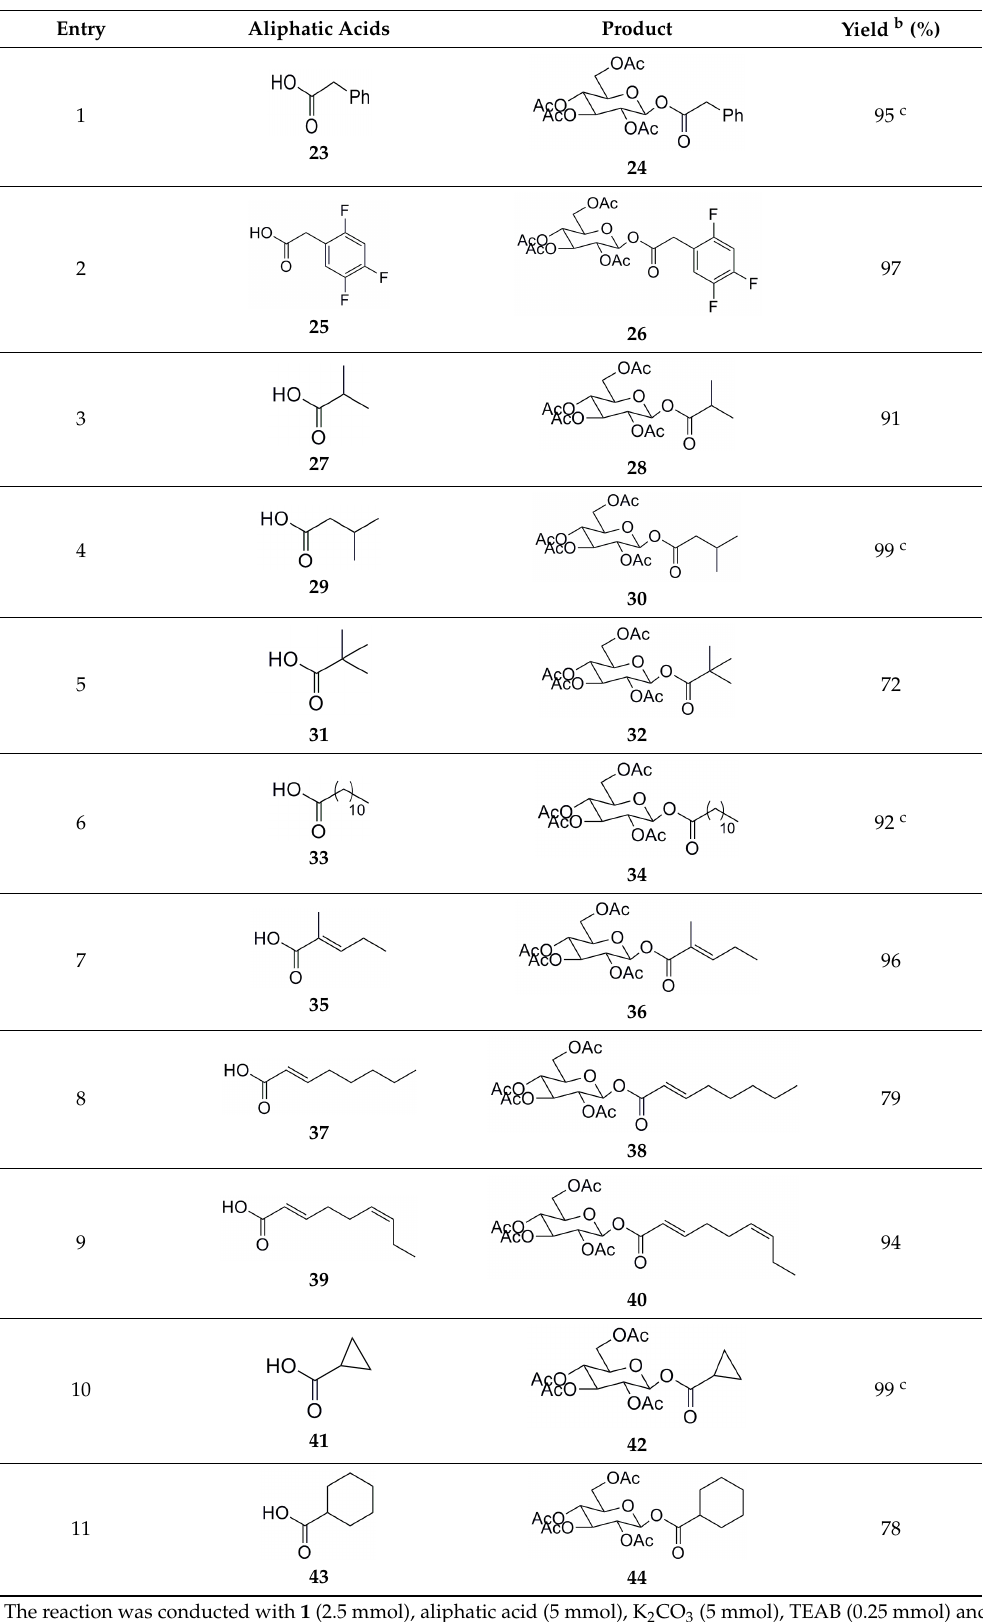
Table 4. The reaction of glucosyl bromide 1 with aliphatic acids a .